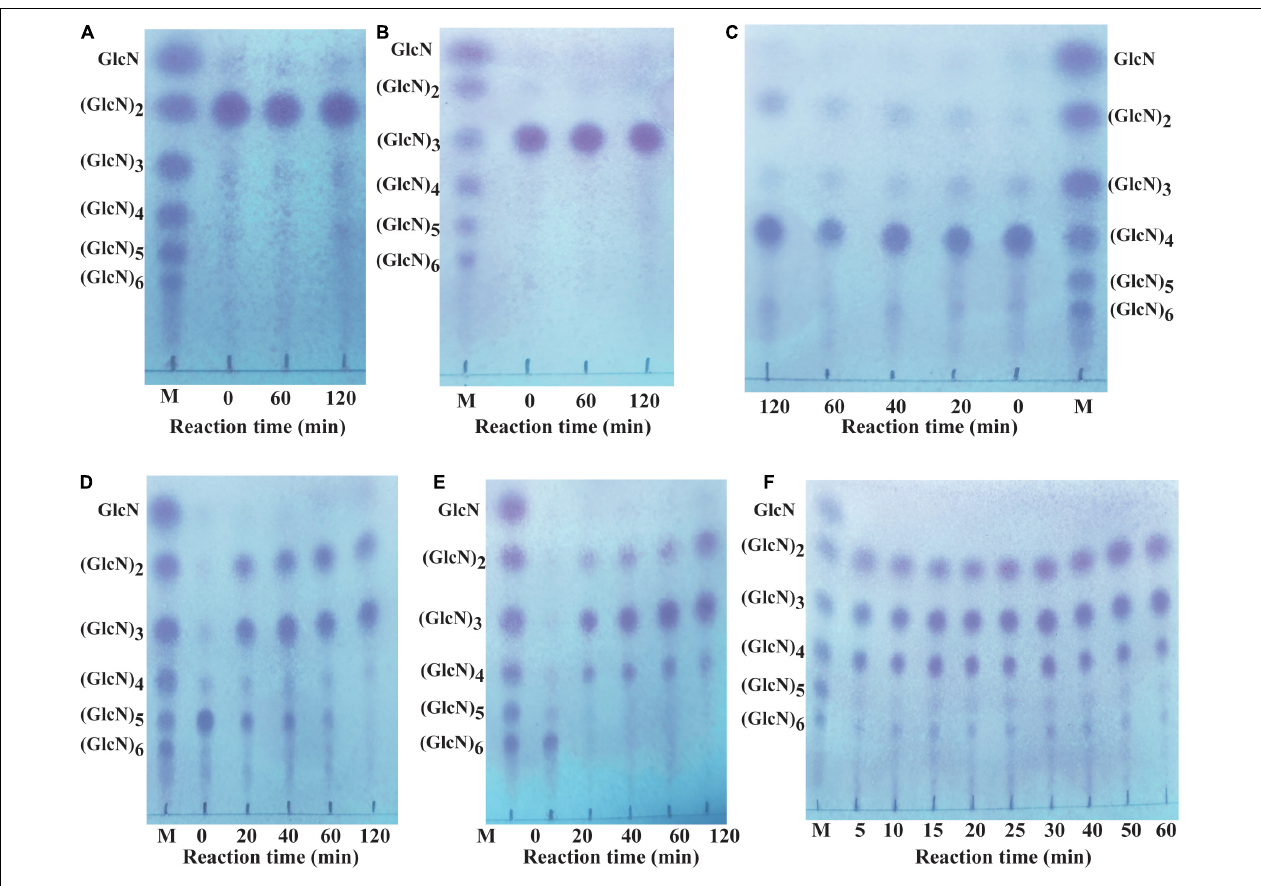
FIGURE 4 | Analysis of the hydrolytic process of CsnBm toward COSs and 0.5% colloidal chitosan. Chitobiose (A) , Chitotriose (B) , Chitotetraose (C) , Chitopentaose (D) , Chitohexaose (E) , and 0.5% colloidal chitosan (F) . M, marker sugars containing GlcN, (GlcN) 2 , (GlcN) 3 , (GlcN) 4 , (GlcN) 5 , and (GlcN) 6